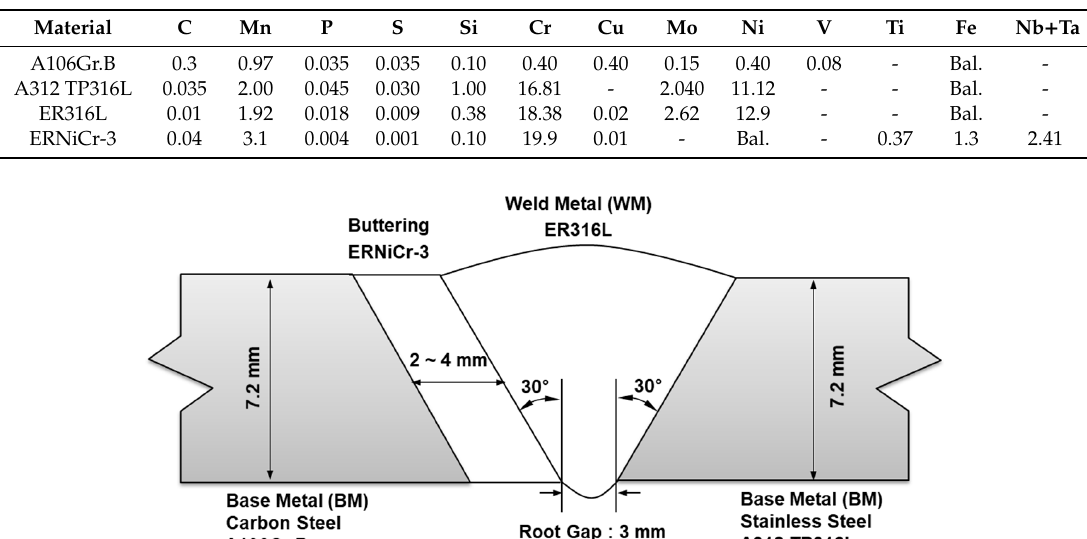
Table 1. Chemical compositions of base metals and filler wires (wt%).